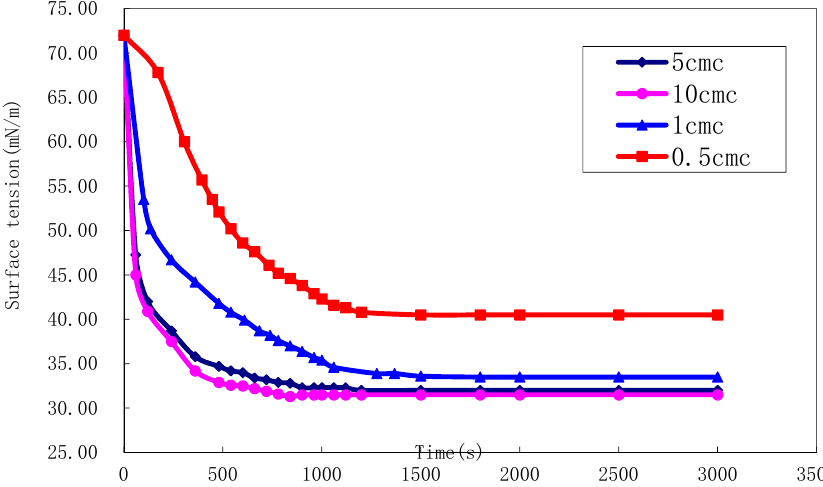
Figure 21. Surface tension of different critical micelle concentration of nanophilic